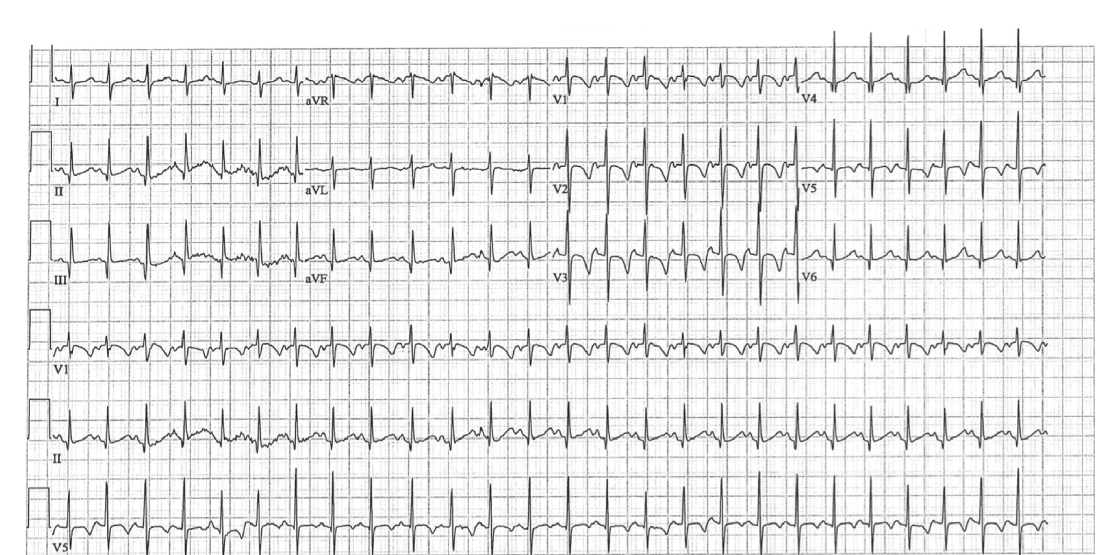
Figure 1: The 12-lead ECG of our